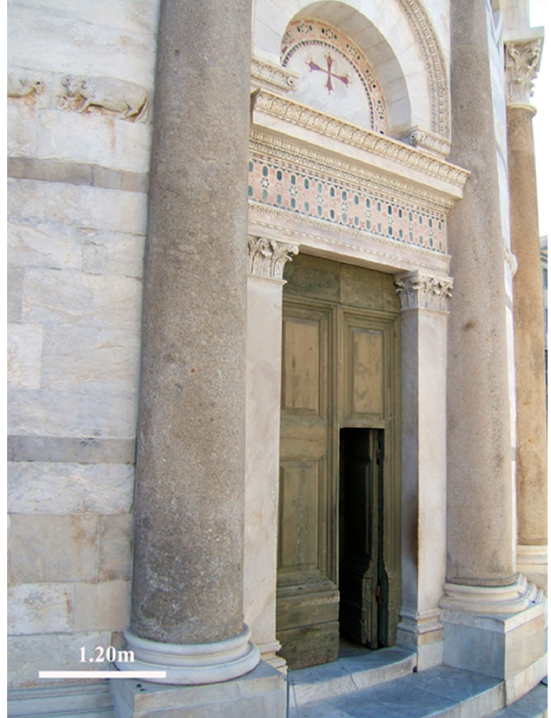
Figure 2. Columns of Giglio granite at the base of the Pisa Bell Tower.